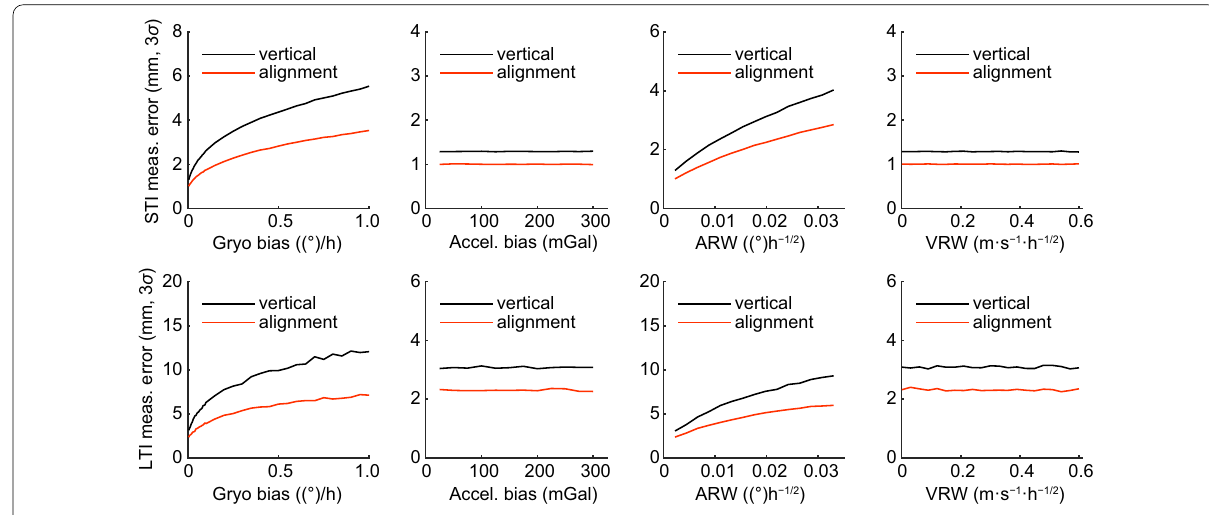
Fig. 8 Track irregularity measurement error caused by principal inertial sensor errors